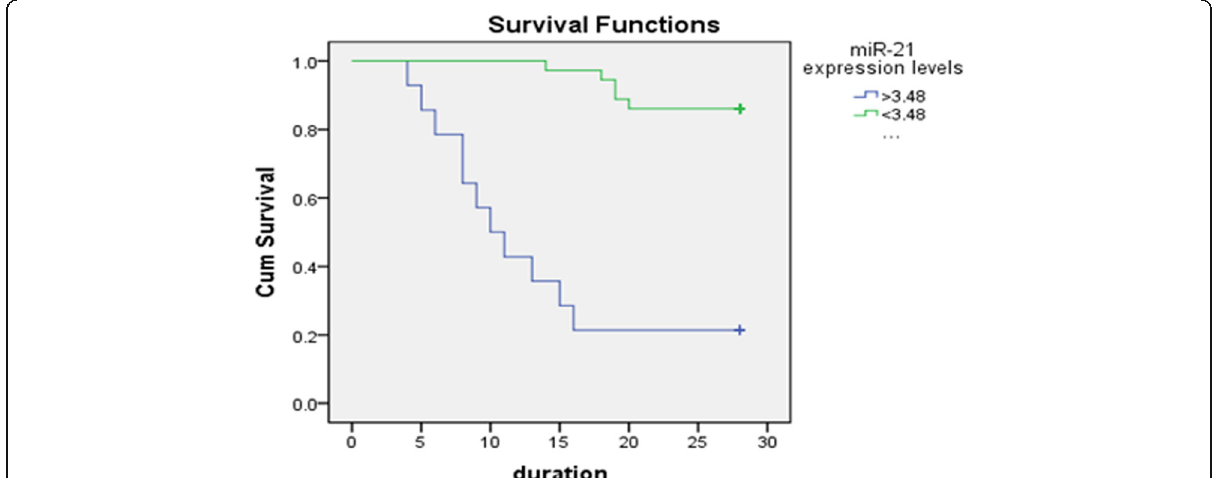
Fig. 3 Kaplan-Meier survival curves of septic neonates based on miR-21 expression